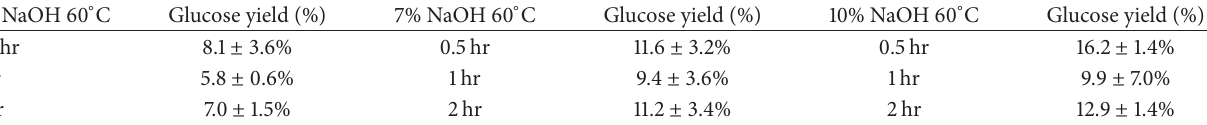
Table 3: Peak glucose production in cellulose hydrolysis systems of sawdust pretreated with NaOH at 60 ∘ C.